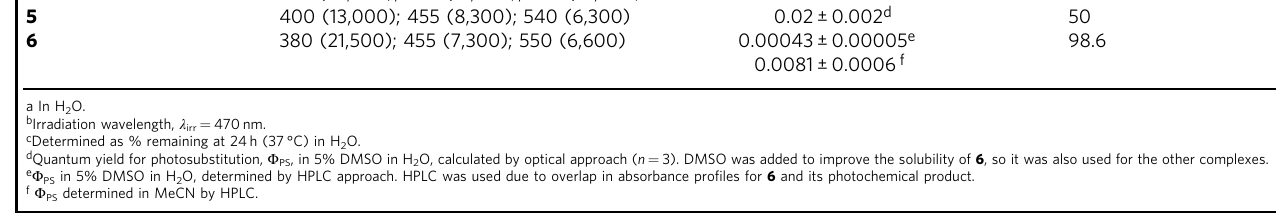
Table 2 Thermal stability, photophysical, and photochemical properties of compounds 4 – 6. Compounds